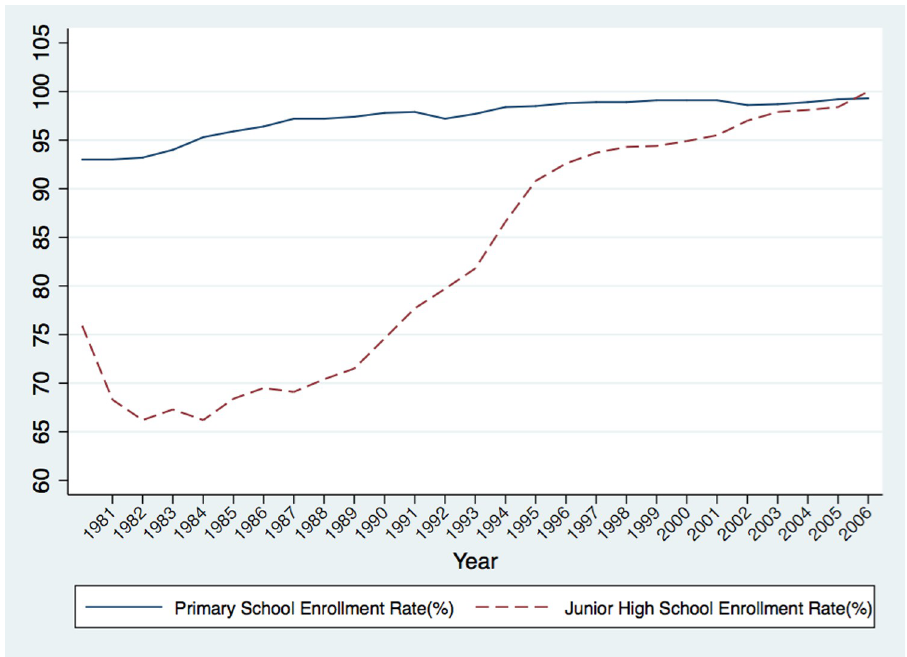
Fig 1. School enrollment rate in China 1981–2006. Note: This figure illustrates the school enrollment rate in China over the period between 1981 and 2006. The solid line represents the primary school enrollment rate and the dashed line represents the junior high school enrollment rate. Data source is National Bureau of Statistics of